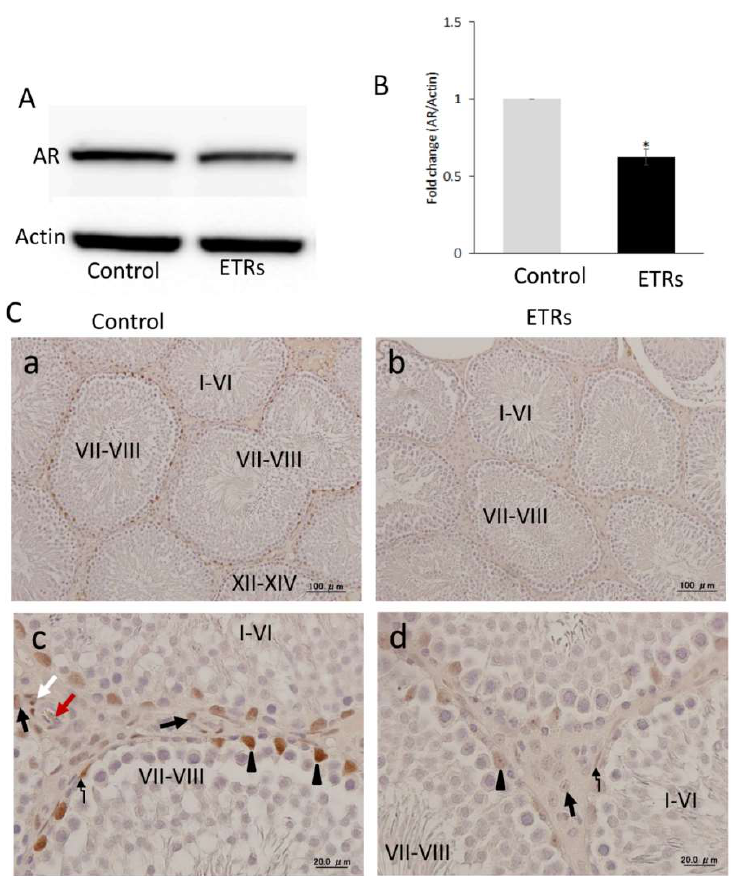
Figure 1. Ethanol-induced reduction of androgen receptor (AR) expression in ETRs testes. ( A , B ) Western blot analysis for AR. The relative expression level for protein was normalized to actin and expressed as fold change relative to the control ( n = 3). * p < 0.01 compared to the control group. ( C ) Immunohistochemistry (IHC) of AR in control (a,c) and ETRs (b,d). Arrow heads indicate nuclear staining of AR in SCs, while broken arrows mark its expression in myoid cells. The black and white arrows indicate the expression of AR in Leydig cells and smooth muscles of blood vessels, respectively (red arrow: blood vessel lumen).